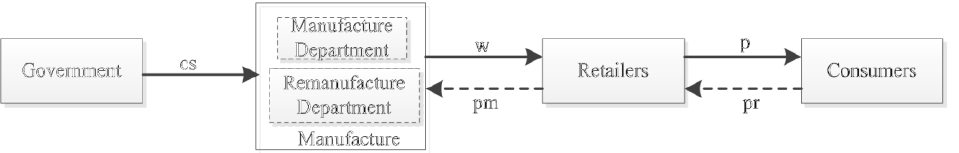
Figure1. The closed-up supply chain under government subsides. Figure 1. The closed-up supply chain under government